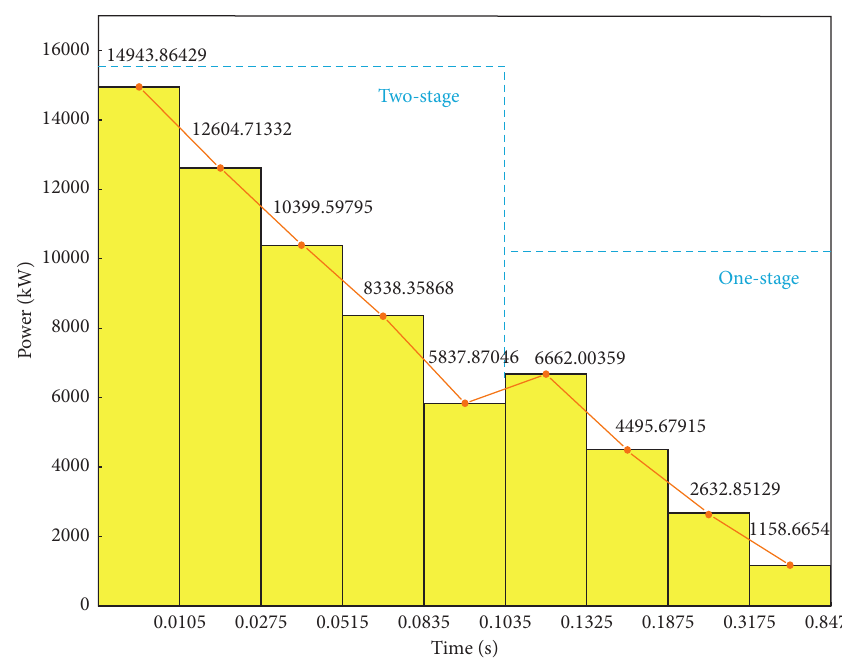
Figure 16: Relationship between power and time during water discharging. Table 4: The setting of pressure relief